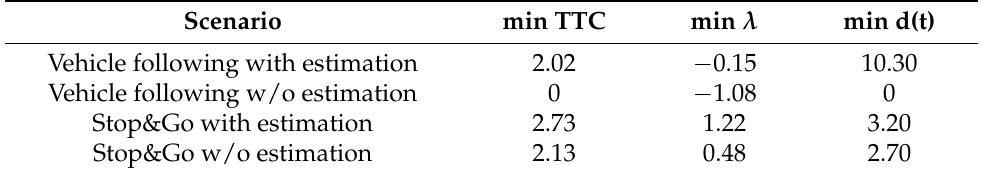
Table 2. Summary of the minimal values assumed by the safety indexes in every described